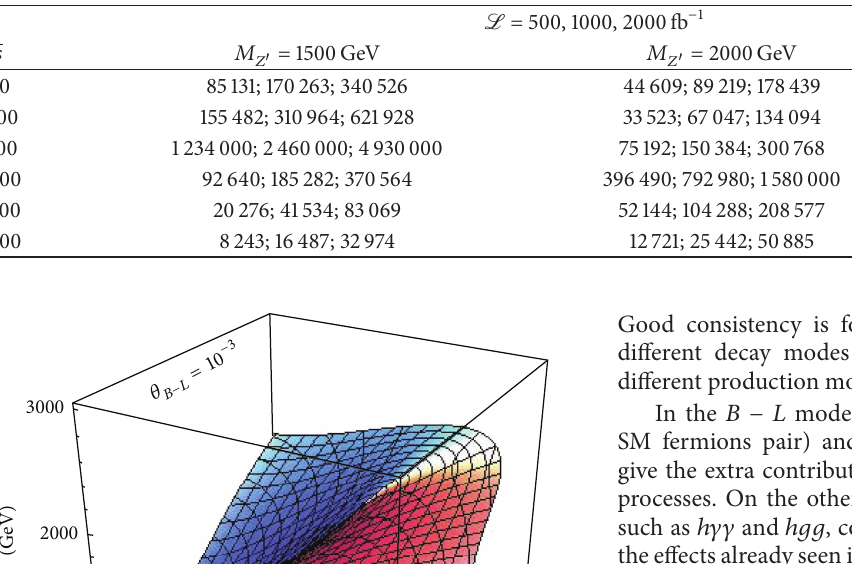
Table 1: Total production of ZH in the 𝐵 − 𝐿 model for 𝑀 𝑍 󸀠 = 1500, 2000, 2500 GeV, L = 500, 1000, 2000 fb −1 (1st, 2nd, and 3rd numbers, respectively, in the last 3 columns), 𝑀 𝐻 = 125GeV, 𝑔 󸀠 1 = 0.5 , and 𝜃 𝐵−𝐿 = 10 − 3 .